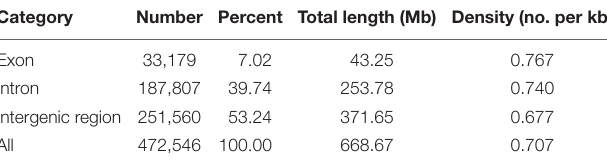
TABLE 2 | Distribution of available SNPs in large yellow croaker genome.